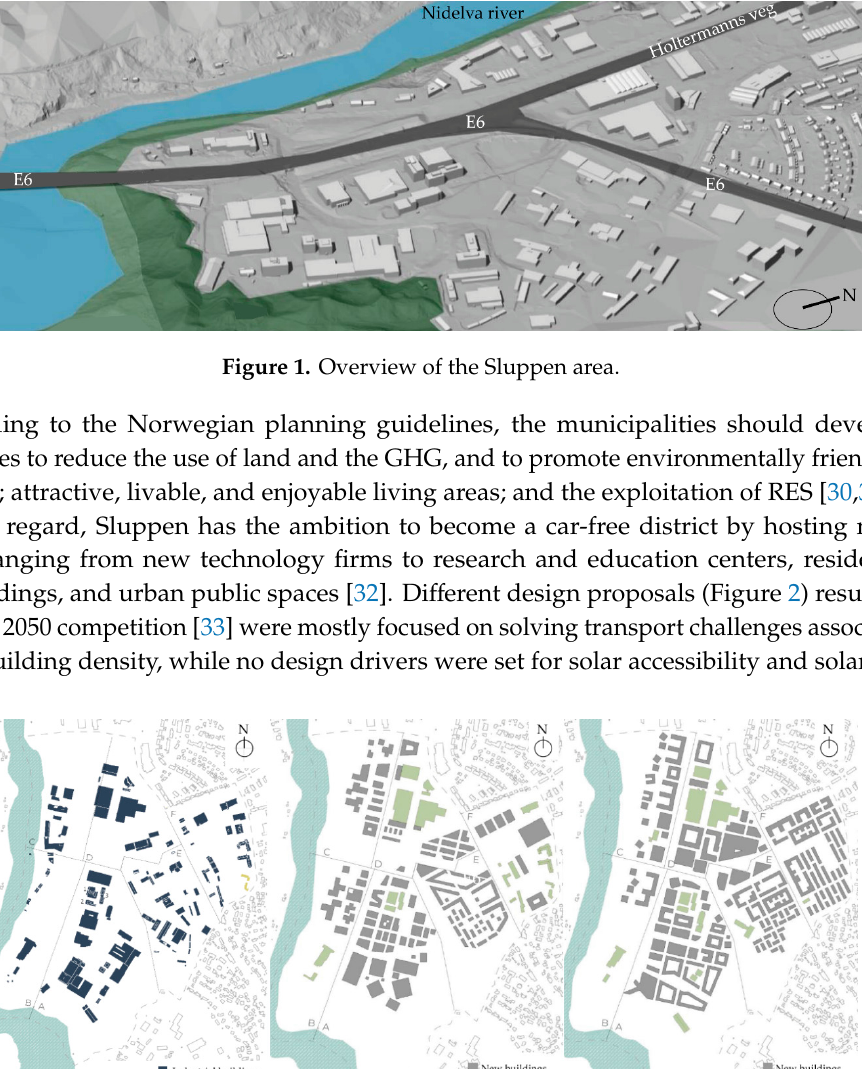
Figure 2. New and existing buildings in the existing situation ( a ), feasibility studies I ( b ) and II ( c ).